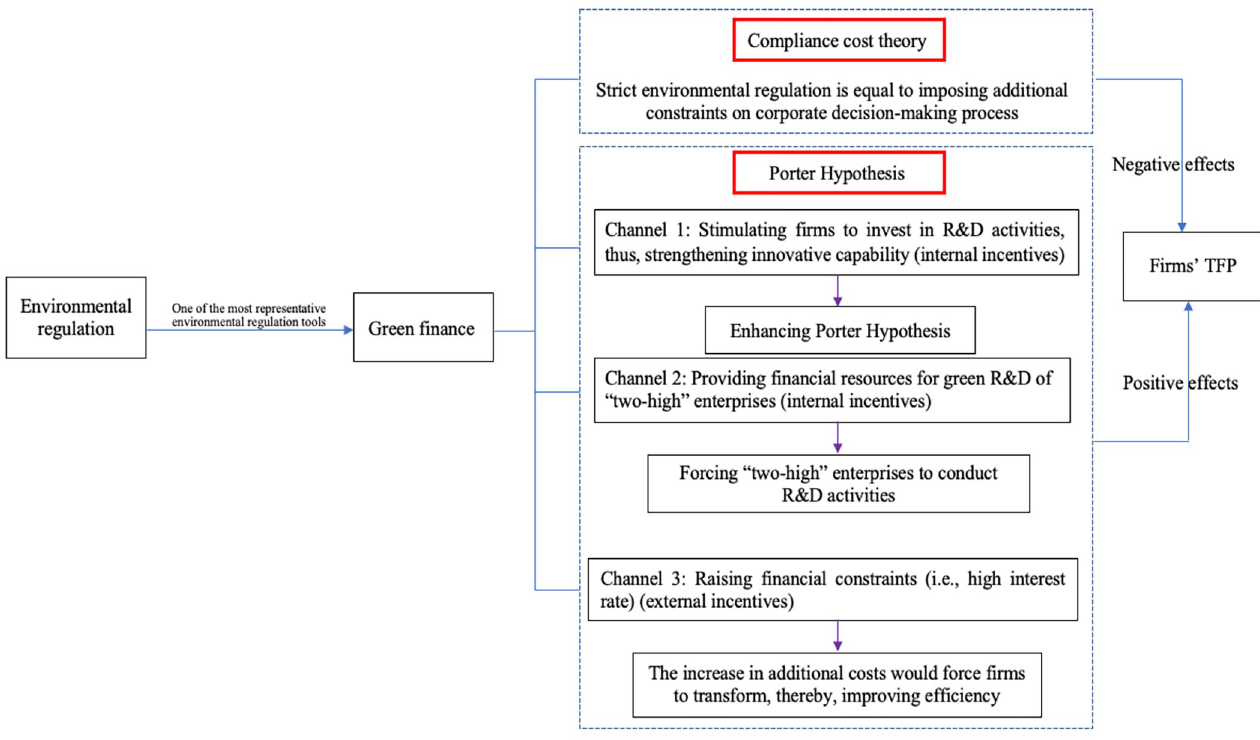
Fig 1. Theoretical notion.